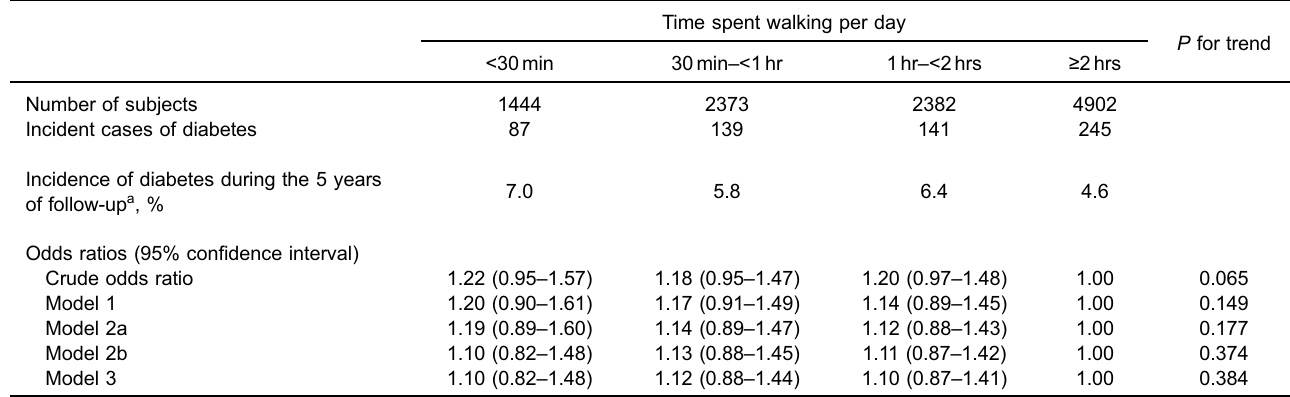
Table 5. Time spent walking per day and the incidence of diabetes (longitudinal analysis)